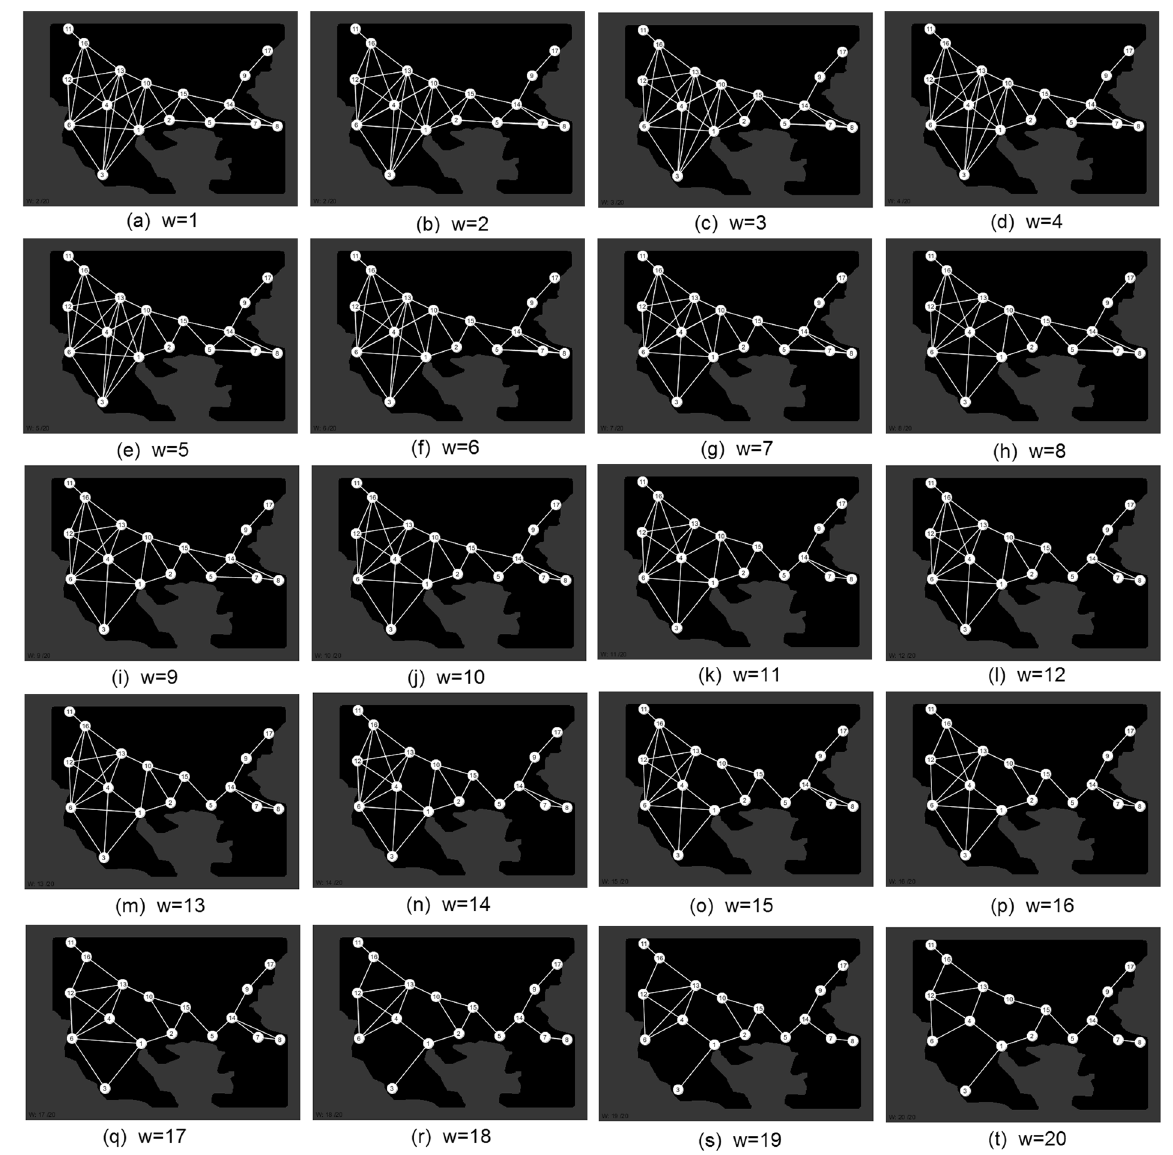
Figure 14. Changes in network connectivity over 20 experiments as edge weight increases, heightfield representation condition. ( a–t ) Graph of final connectivity corresponding to w value (Connectivity analysis of simulation results from custom Processing script (https://www.processing.org/) by author